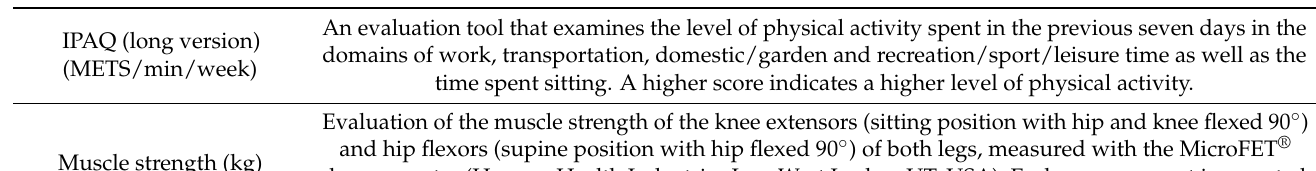
Table A3. Additional frailty